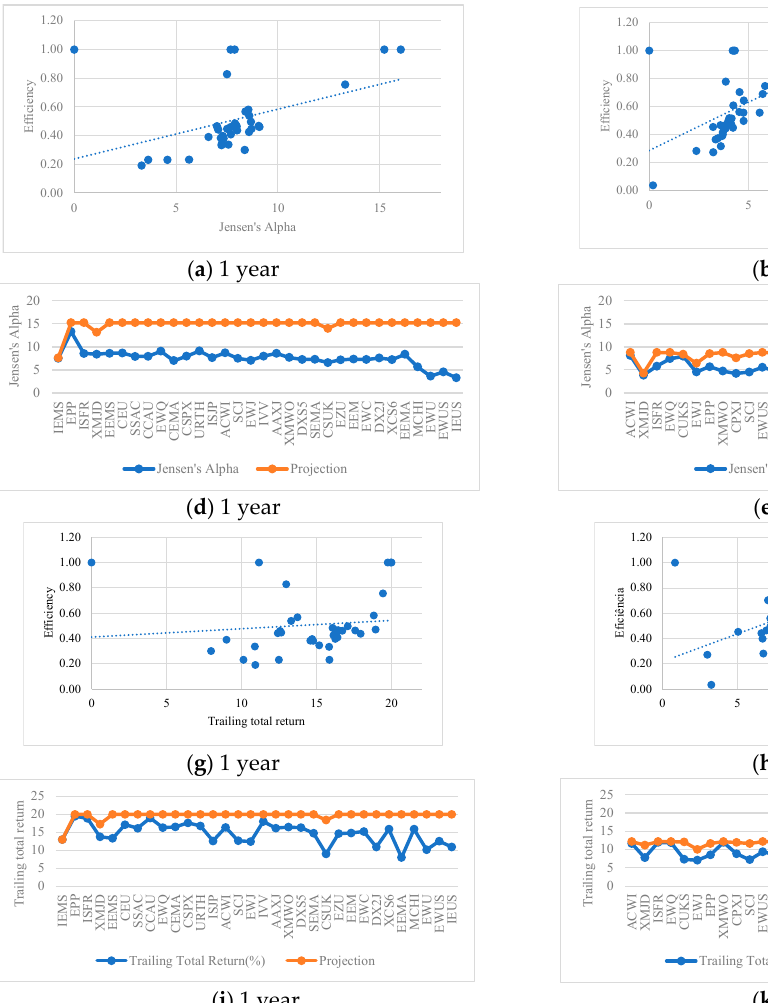
Figure 4. Efficiency scores vs. outputs and projections (ETFs are ordered in decreasing order of efficiency) for the different time horizons–M2.